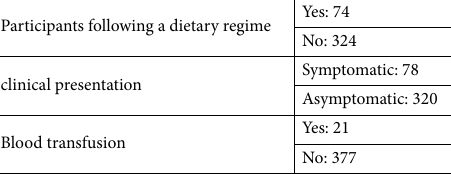
Participants following a dietary regime